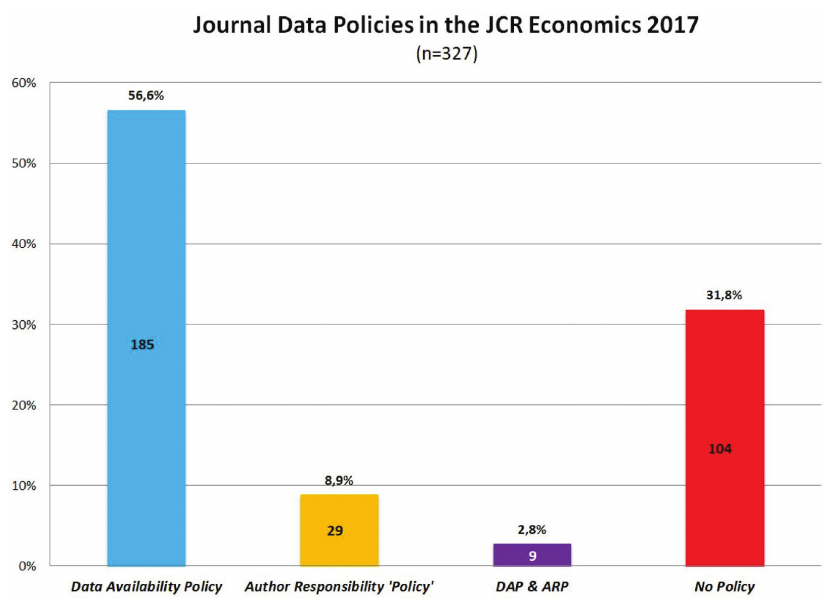
Fig. 1: Data Policies found in the sample of 327 journals that accept or publish empirical or other data-driven